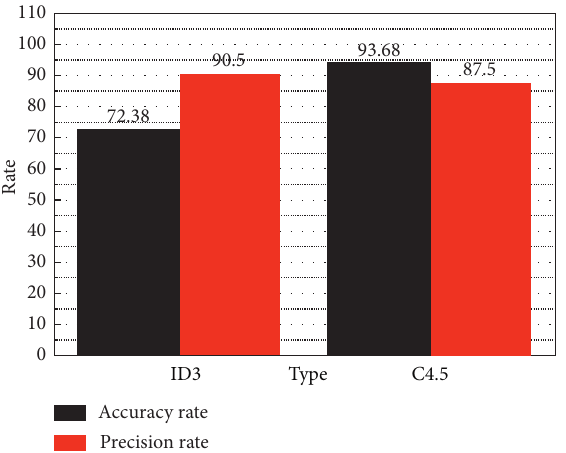
Figure 10: Accuracy rate and precision